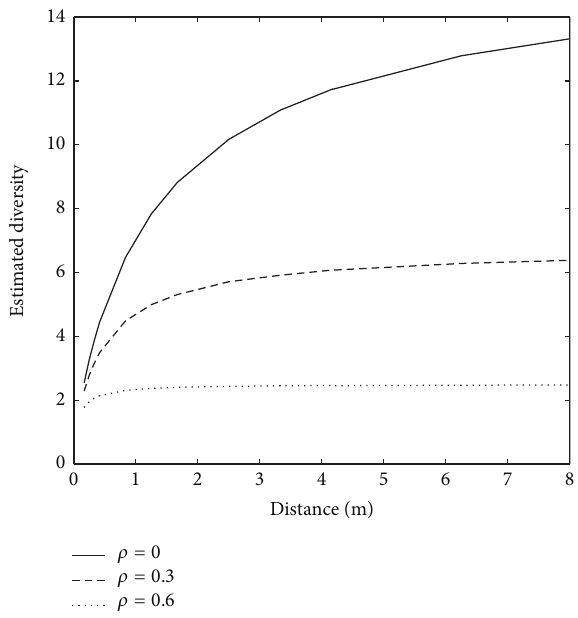
Figure 7: Estimated diversity (8) for correlated fading model at 30 km/hr for 2